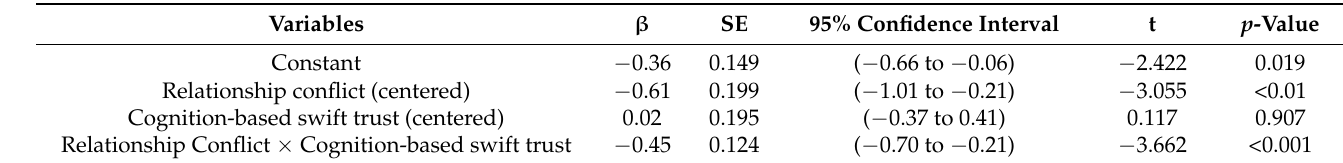
Table 3. Regression analysis parameters examining whether the scores for relationship conflict (RC) for student teams ( N = 54) moderate relationships between cognition-based swift trust subscale and team creativity